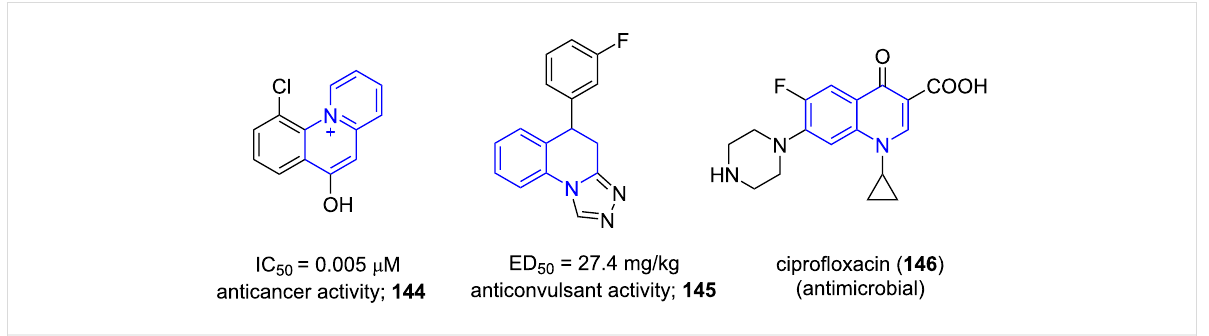
Figure 11: Pharmaceutically important molecules with quinoline